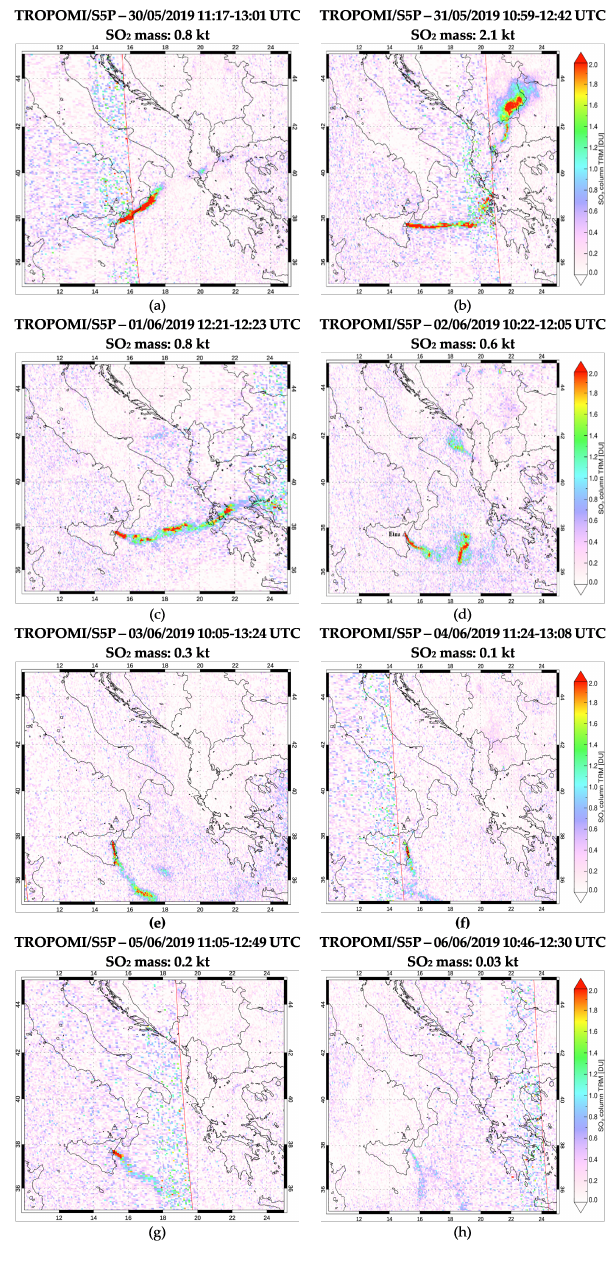
Figure A1. SO 2 mass burden collected by TROPOMI/S5P, data from: BIRA-IASB/DLR/ESA/EU Copernicus Program. The SO 2 mass burden varies over Etna from day to day: ( a ) on 30 May